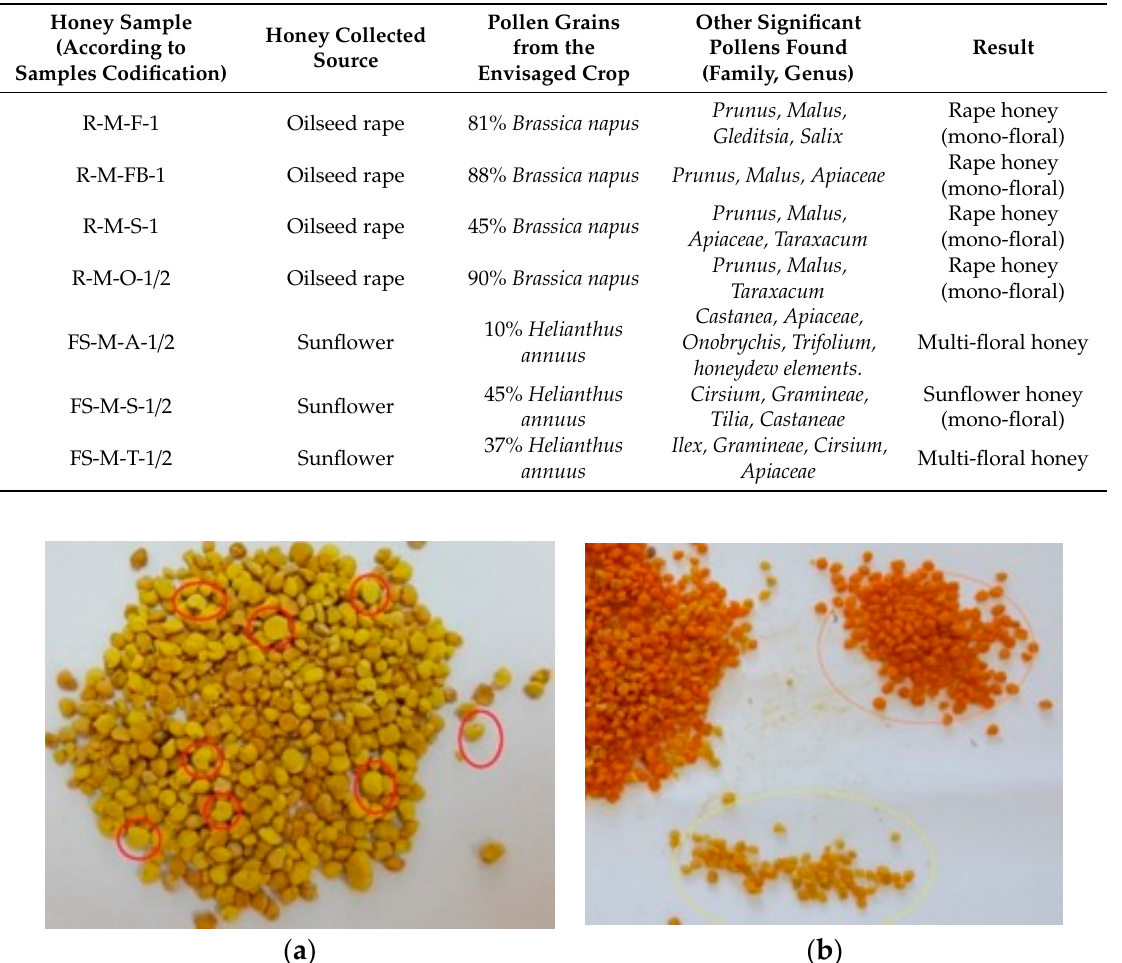
Table 1. The obtained results on di ff erent types of honey samples, following the mellissopalinological analyses.